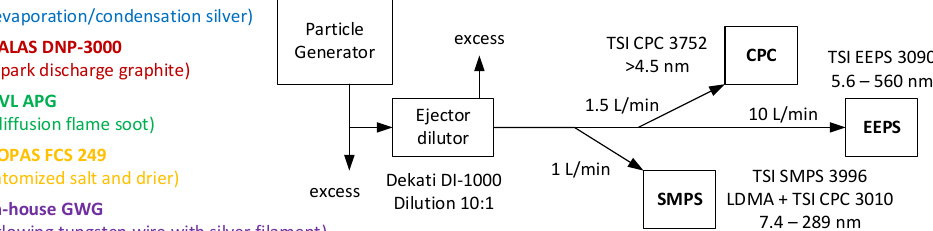
Figure 1. Experimental setup. C.I. = Catalytic Instruments; CPC = condensation particle counter; EEPS = engine exhaust particle sizer; GWG = glowing wire generator; LDMA = long differential mobility analyzer; SMPS = scanning mobility particle sizer.